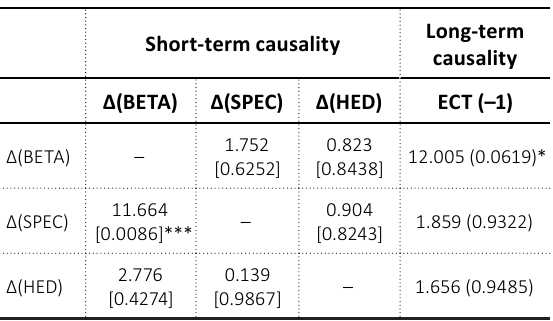
Table 10. The results of the Granger